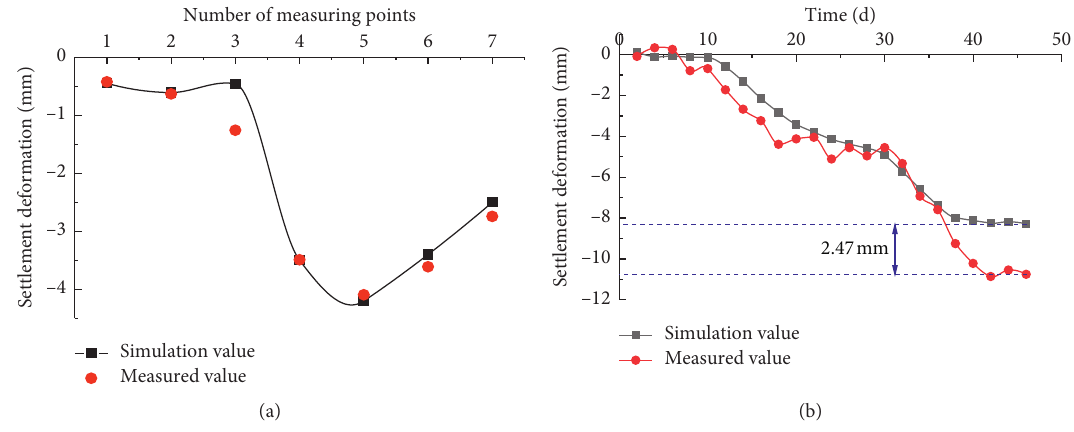
Figure 21: Vertical shaft surface subsidence monitoring comparison: (a) comparison of DB57 series results; (b) comparison of DB56-5